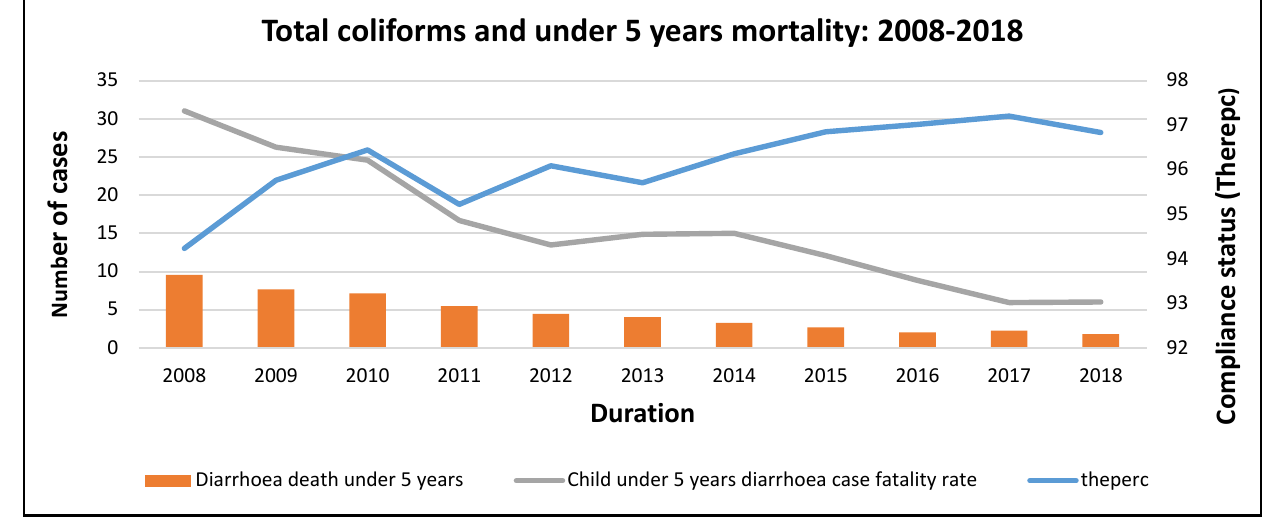
Figure 9. Total coliform and mortality trends at national level.